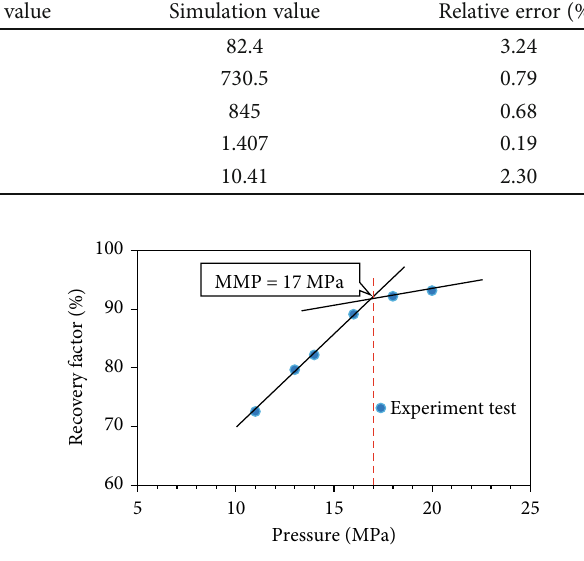
Figure 6: Experiment test results of